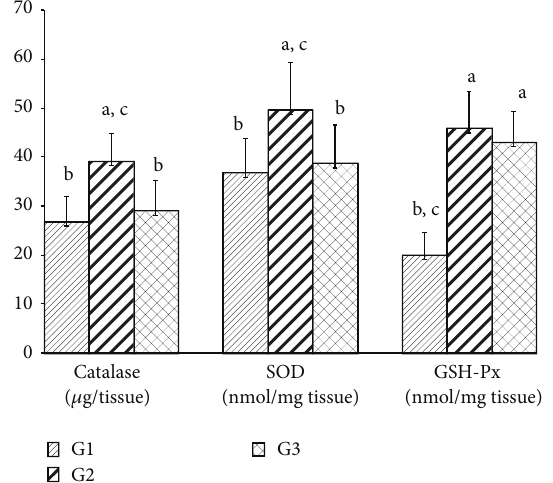
Figure 5: Hepatic activities of catalase, SOD, and GSH-Px after 30 days for all experimental groups. Values are given as the mean ± SD for each group of eight animals. a Significantly different from G1; 𝑃 ≤ 0.05 ; b significantly different from G2; 𝑃 ≤ 0.05 ; and c significantly different from G3; 𝑃 ≤ 0.05 . G1: untreated control; G2: treated with geraniol; and G3: treated with essential